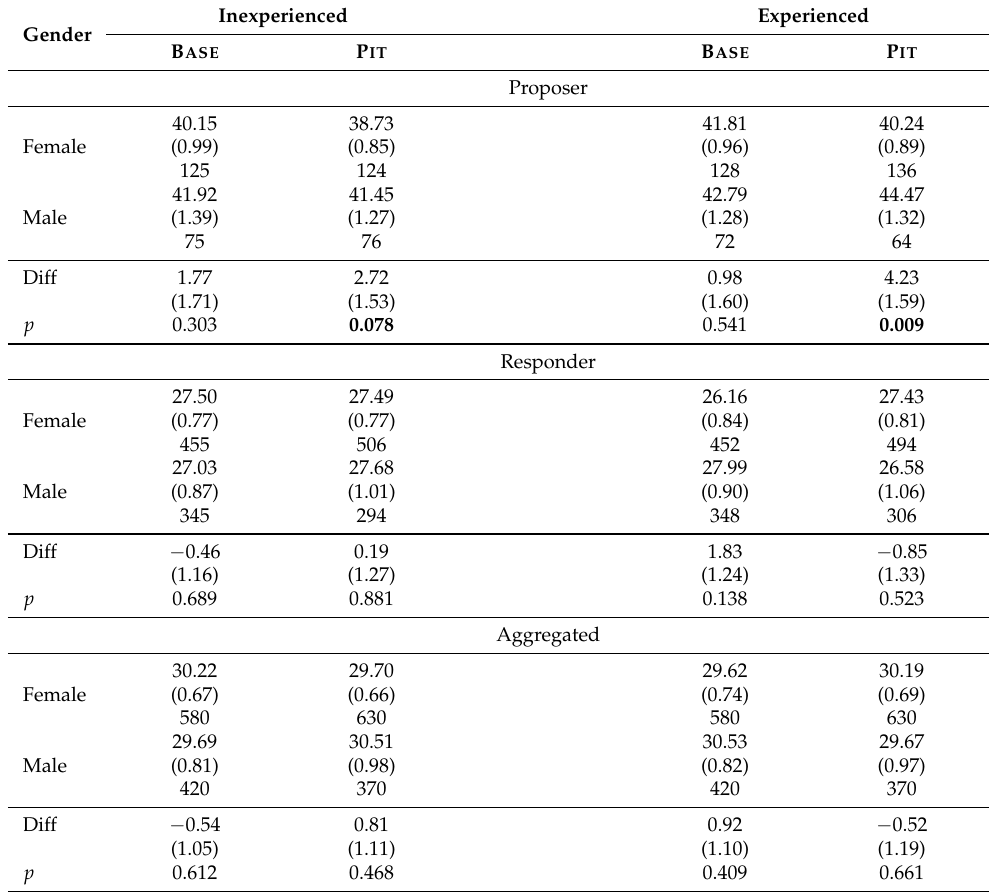
Table A2. Players’ Payoffs by Role, Experience, Treatment, and Gender.